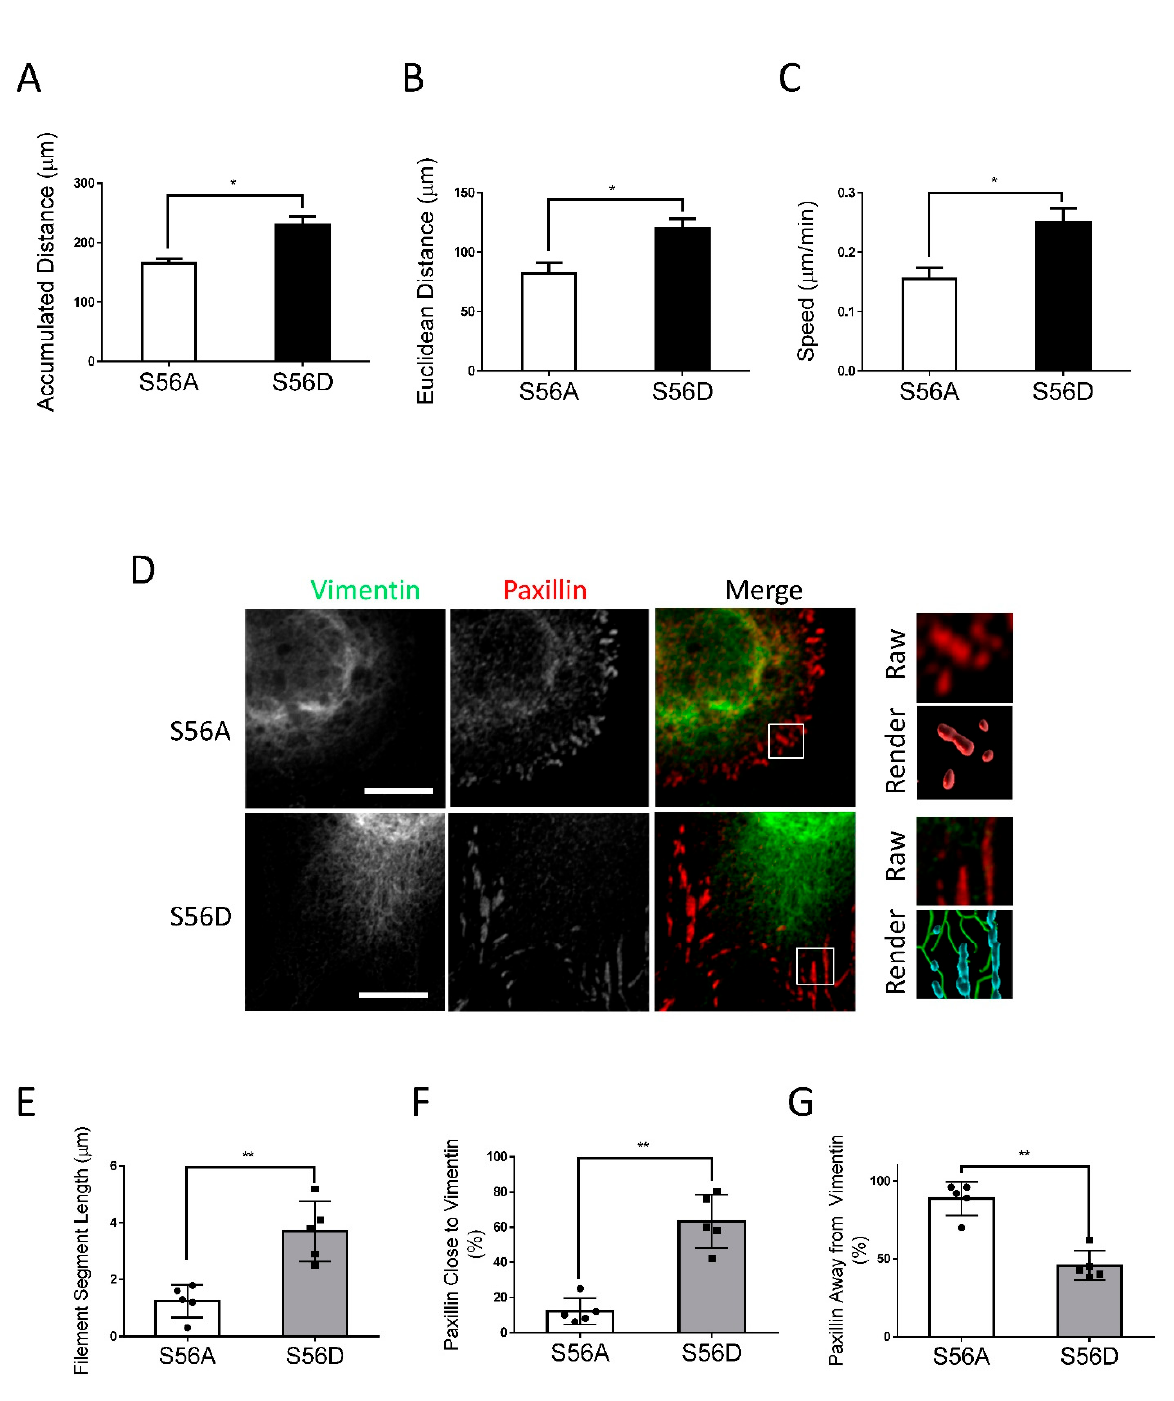
Figure 4. Vimentin S56D affects migration and vimentin network of nestin KD cells. To assess the